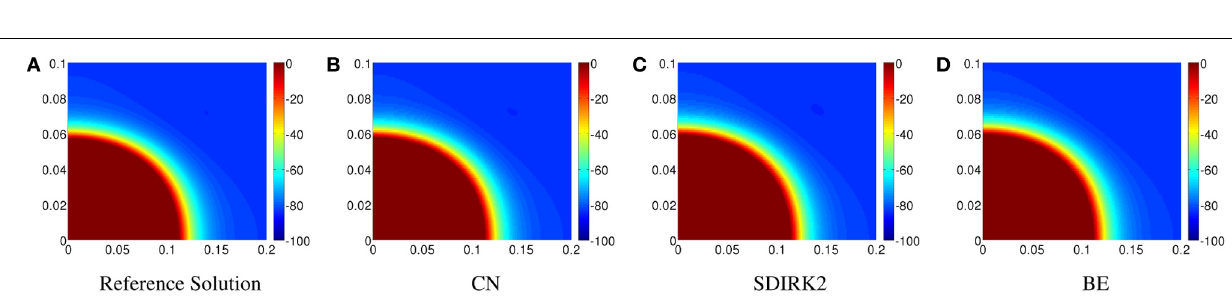
FIGURE 6 | Plots of the transmembrane potential on [0, 0.2] × [0, 0.1]cm at t = 2ms for Scenario II: (A) reference solution, (B) CN solution, (C) SDIRK2 solution, and (D) BE